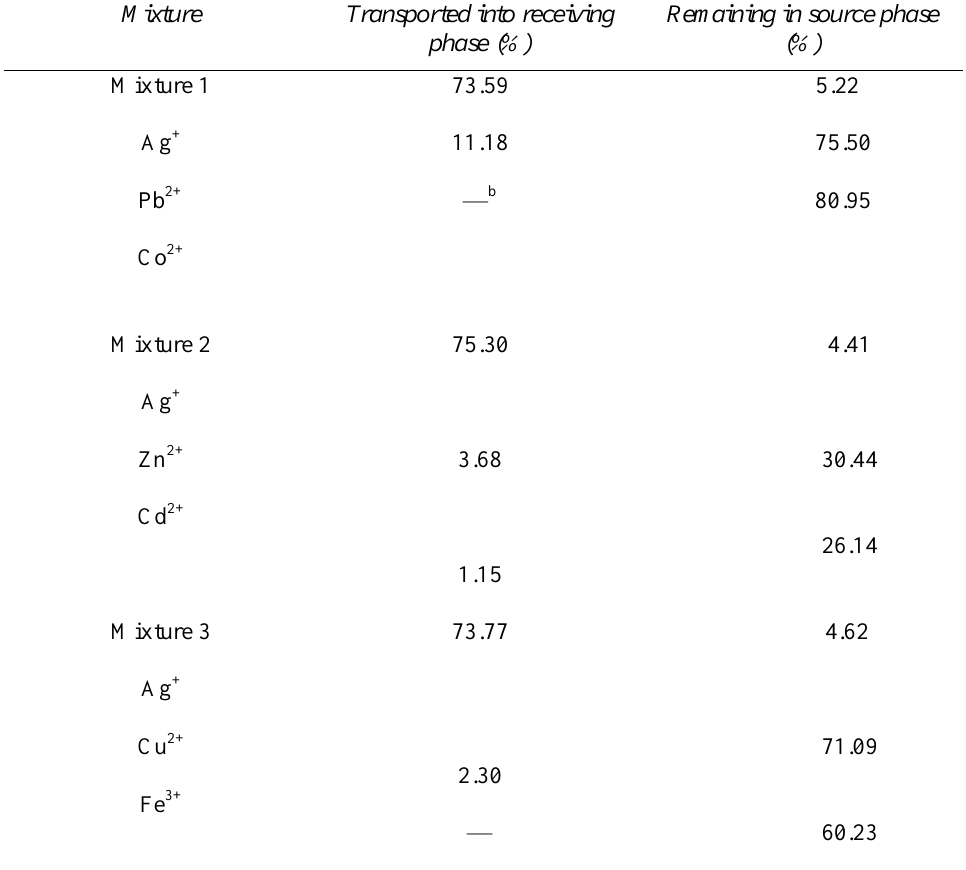
Table 3. Amount of cations transported from various cation mixtures through